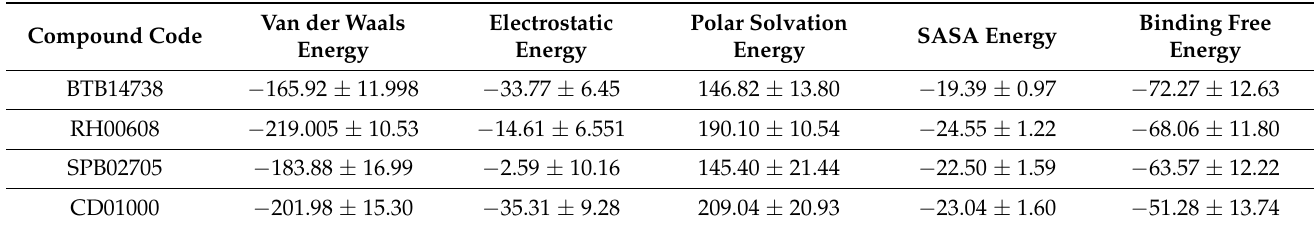
Table 3. The MM/PBSA results for the selected putative hits. All energies are in unit of KJ/mol. Compound Code